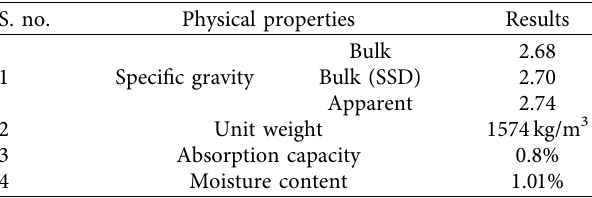
Table 6: Summarized physical properties of the coarse aggregate. S. no.